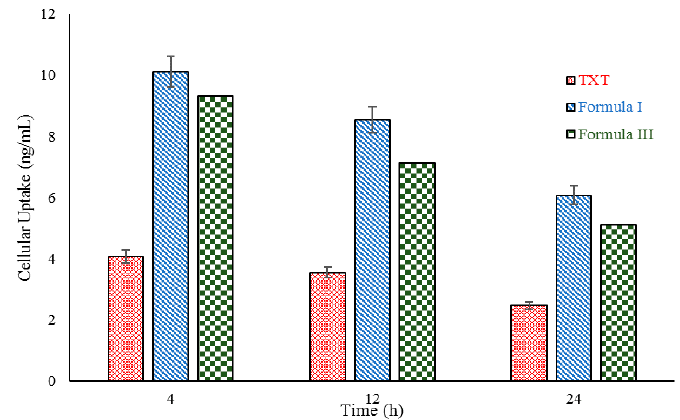
Figure 6. C26 cell DTX uptake in exposure of formulations I, III, and 100 mg/mL TXT at 4, 12, and 24 h.